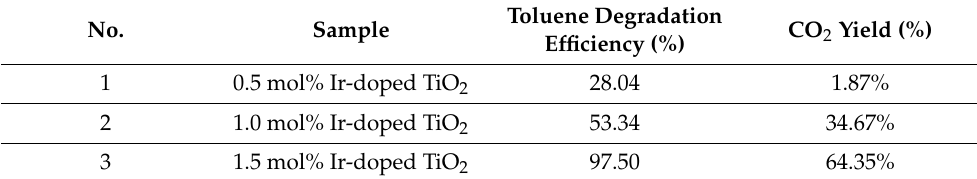
Table 3. CO 2 resulted from the toluene degradation by different ratios of Ir doped into TiO 2 . No.